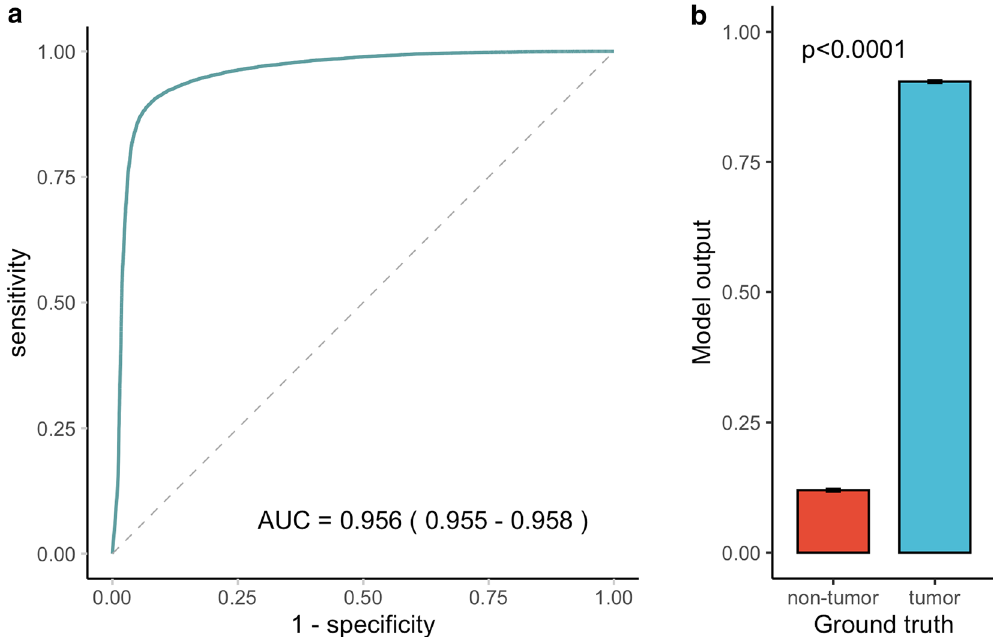
Figure 3. Performance of the tumor tile classification model on the external test set. The AUROC for tumor tile classification was 0.956 (95% CI 0.955, 0.958) on the external test set ( a ). Model outputs differed significantly between tiles with a ground truth of tumor versus non-tumor ( p value < 0.0001) ( b ). *95% CI for AUC is shown in parentheses in the ROC plot. **Error bars represent 95% CI in the bar chart. The p value was computed using the Wilcoxon rank sum test. AUC, area under the ROC curve; CI, confidence interval; ROC, receiver operating